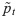
Probability of cooperation in the repeated PDG game on the square lattice having 10 × 10 nodes.(A) Mean time courses of the actual probability of cooperation, p˜t. The lines represent the actual probability of cooperation averaged over the 102 players and 103 simulations. We set β = 0.2 and A = 0.5. The shaded regions represent the error bar calculated as one standard deviation. (B) Probability of cooperation for various values of the sensitivity of the stimulus to the reward, β, and the aspiration level, A. The shown values are averages over the 102 players, the first tmax = 25 rounds, and 103 simulations.